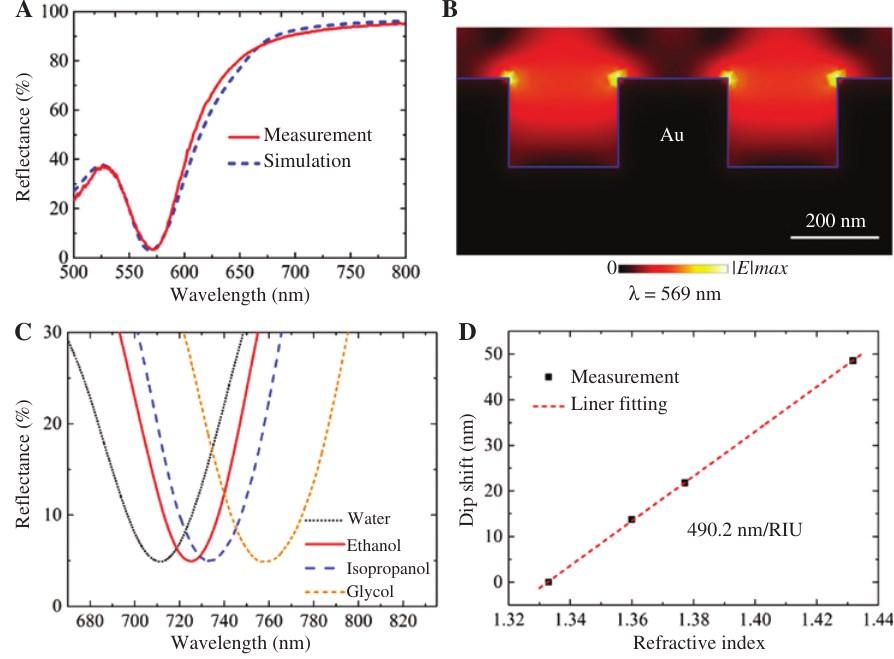
Figure 3: Optical performance of PNA. (A) Measured and simulated reflectance spectra of bare PNA under normal incidence in the air. (B) Electric field distribution for the (1, 0) order plasmonic resonance mode at λ = 569 nm. (C) Reflectance spectra of the (1, 0) order resonance in the PNA for various solvents. (D) Reflectance dip shift of the (1, 0) order resonance as a function of refractive